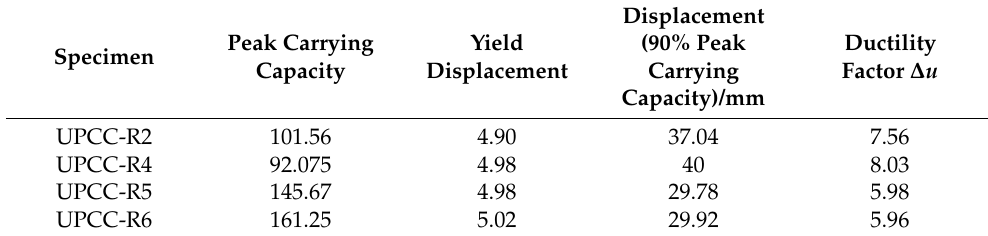
Table 10. The ductility coefficient of specimens under EREDL with different yield strength.